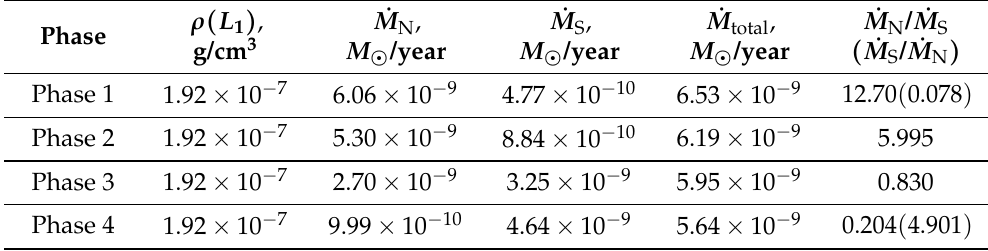
Figure 11. The same as in Figure 10, but for Phase 3 ( upper panel)) and Phase 4 ( lower panel). Table 6. Parameters of matter accretion to the white dwarf in the asynchronous polar with offset dipole for various phases of switching the flow from the north pole to the south